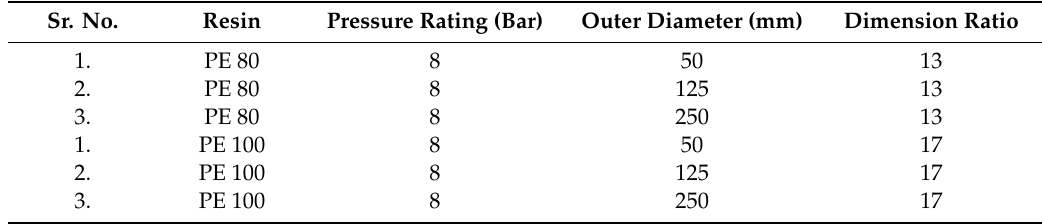
Table 2. Detailed specifications of PE enclosure specimens used in the structural flexibility